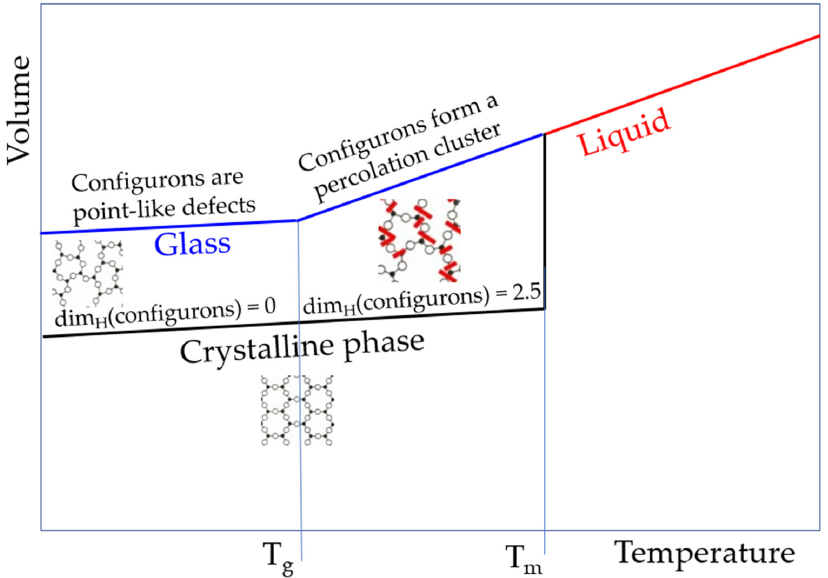
Figure 5. Schematic of specific volumes of stable glass (T < T g ), supercooled melt (T g < T < T m ), and stable melt (T > T m ). For silica, T g = 1980 K and T m = 1986 K. The molar volume of silica melt is 27.4 cm 3 /mol. Note that the slope of lines is significantly exaggerated for the amorphous silica to account for the very low expansion coefficient, which is not higher than 4.9 × 10 − 6 K − 1 for the glassy phase and not higher than 7 × 10 − 6 K − 1 for the melt [1].